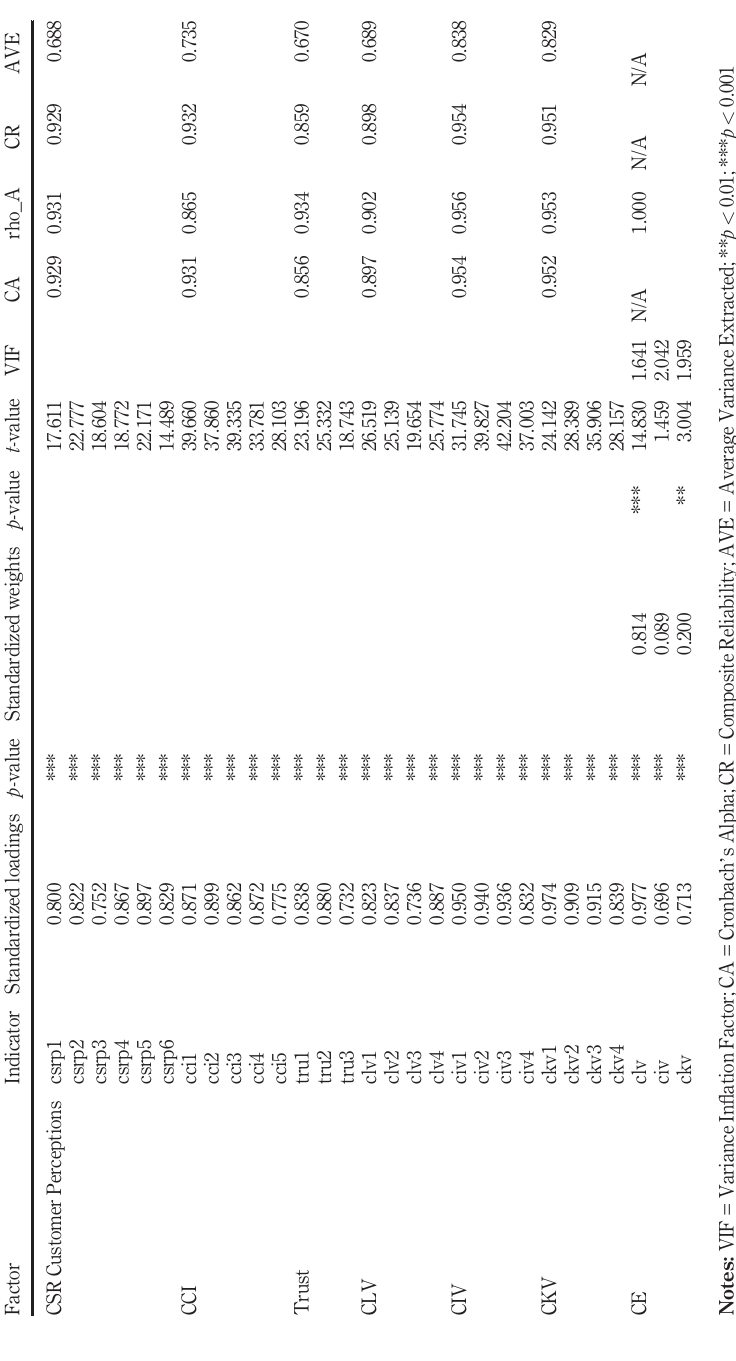
Table V. Measurement model. Convergent validity and